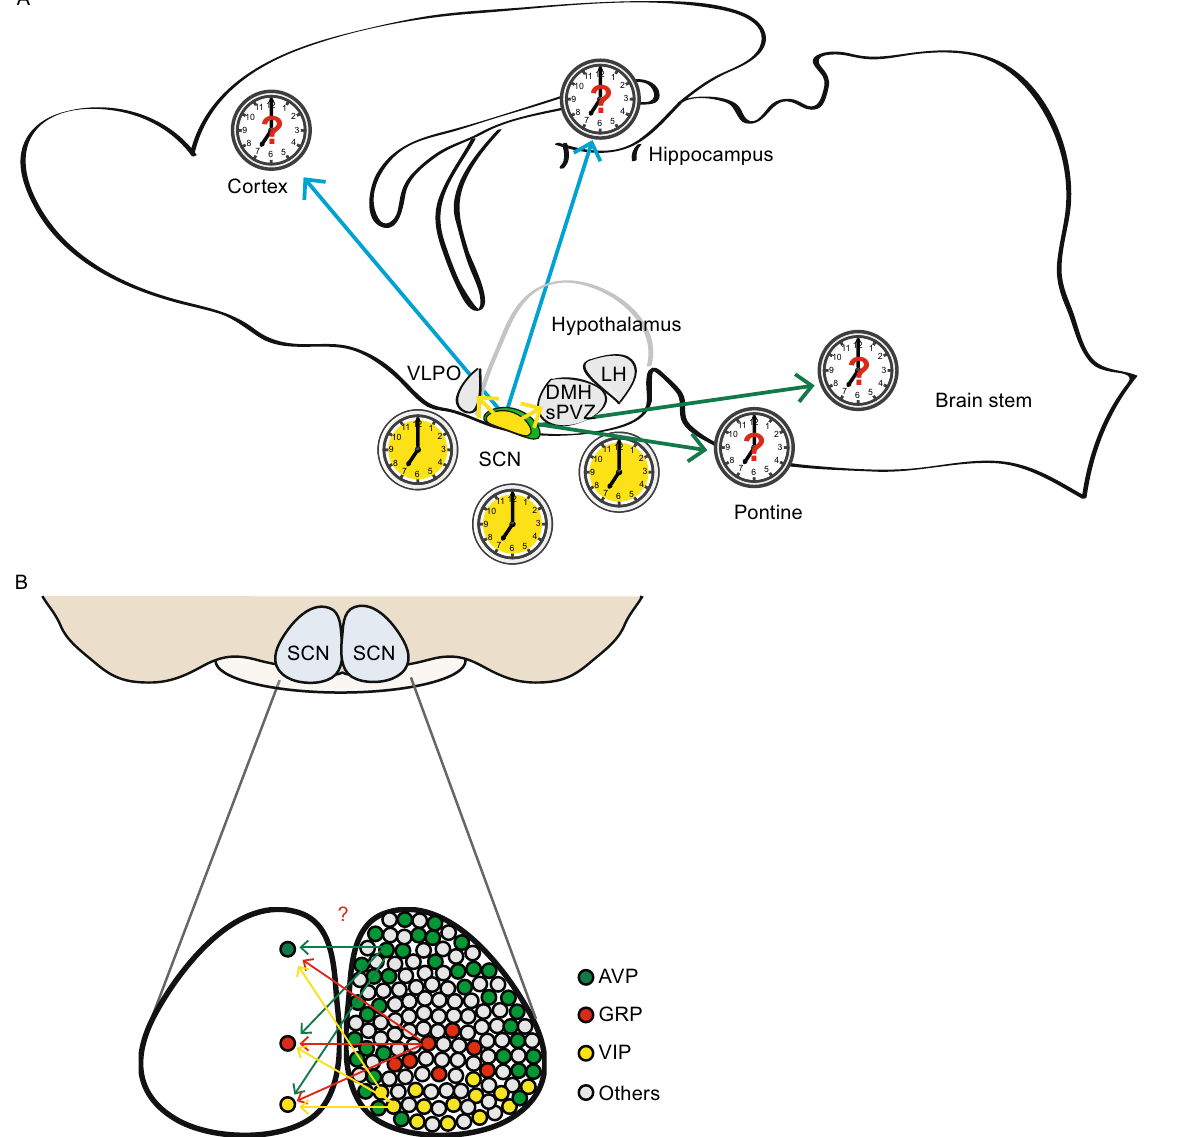
Figure 2. Schematic functional map of circadian control. Studies have demonstrated the SCN efferent primarily travel to other hypothalamic nuclei incuding dorsomedial hypothalamus (DMH), subparaventricular zone (sPVZ) and more. A map of direct SCN neuron projections to sleep-awake or cognitive centers in the brain (A) and the intra-SCN (bilateral) connectomes (B), with the details in connection density and neuron types, remains elusive at the